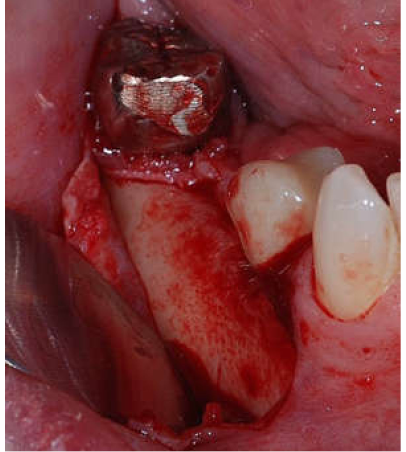
Figure 3. Intra-operative clinical aspect after flap opening.